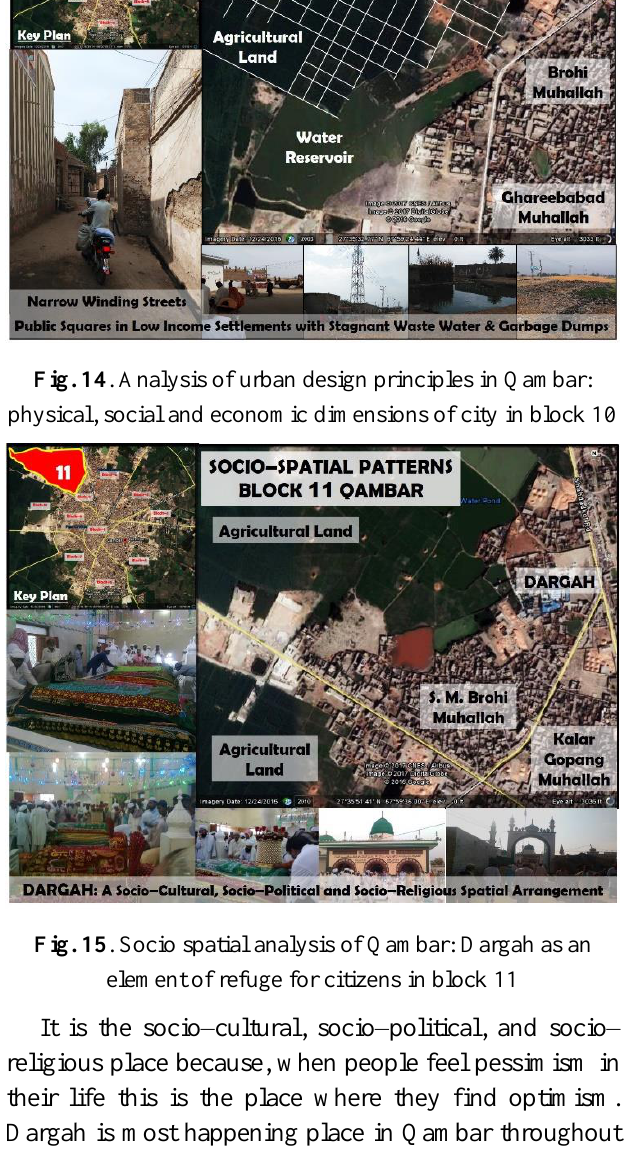
Fig. 17 . Analysis of urban artefacts in formal and informal realm of